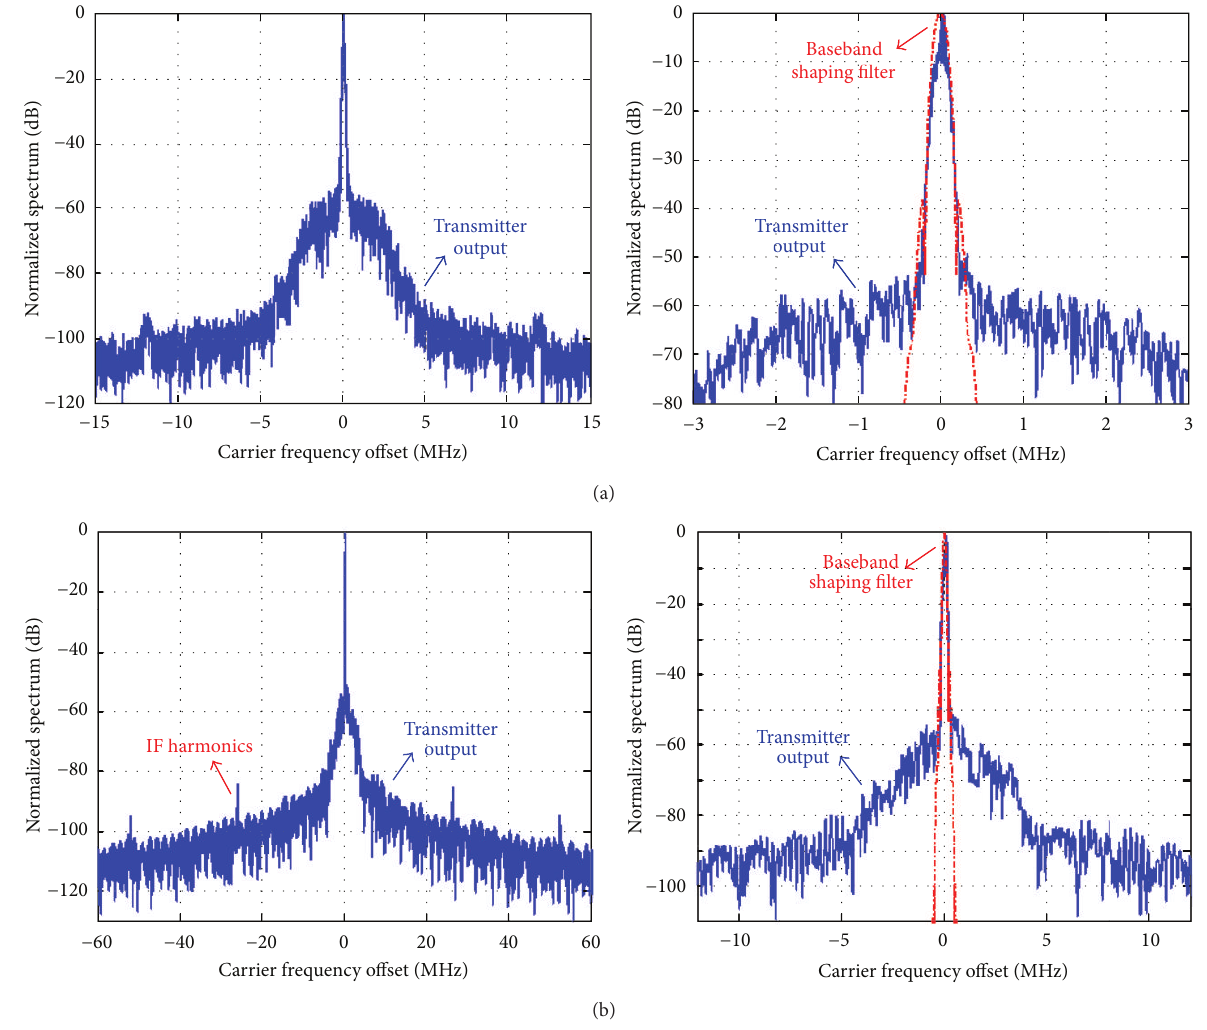
Figure8:Simulatedtransmitternormalizedfarandnearspectrums:(a)CF-PWMcenteredat50 MHz;and(b)IF-PWMcenteredat200 MHz.